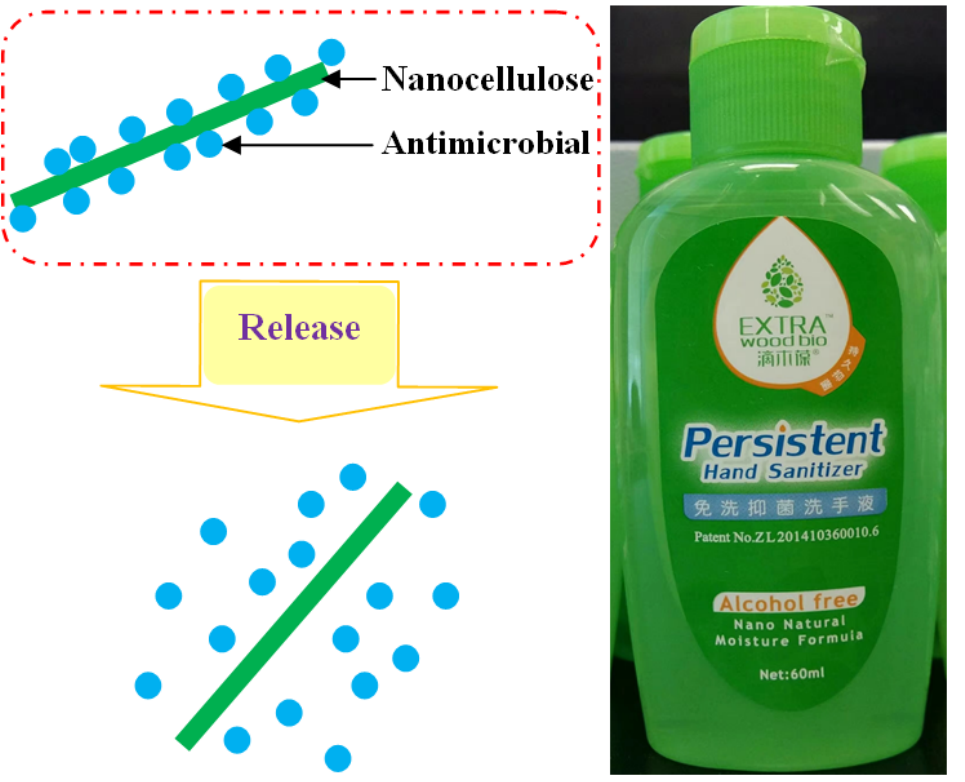
Figure 8. Loading and release mechanism of the nanocellulose ‐ formulated hand sanitizer.